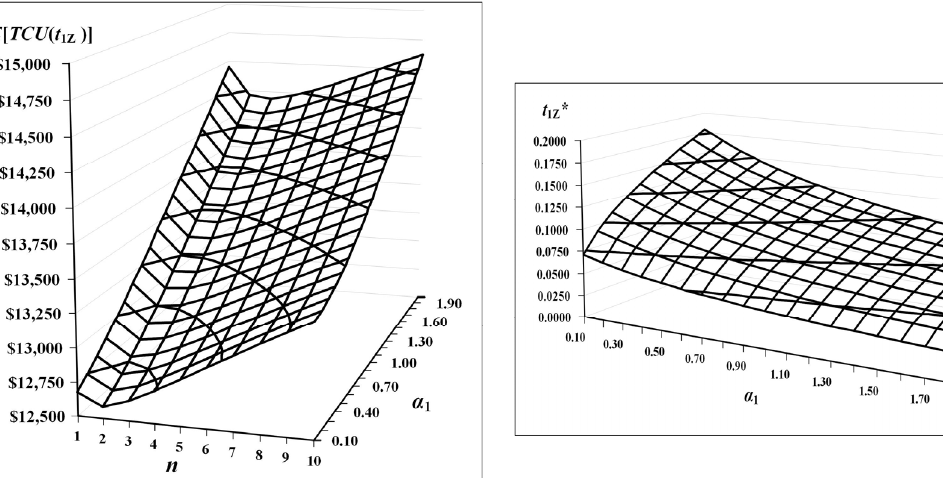
Fig. 9. Joint influence of variations in α 1 and n on Fig. 10. Joint influence of changes in α